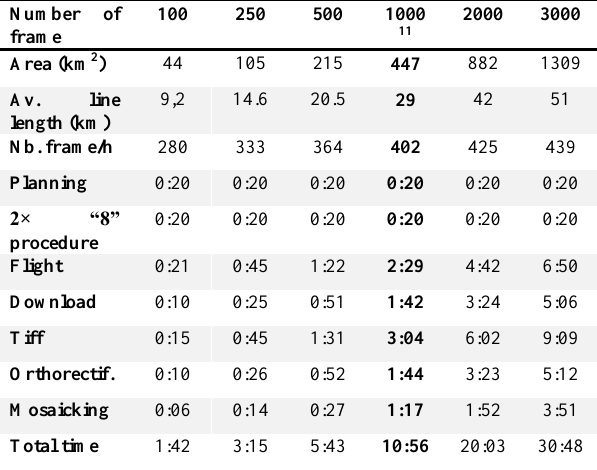
Table 6. Calculation of total time for different sizes of projects 11 Reference